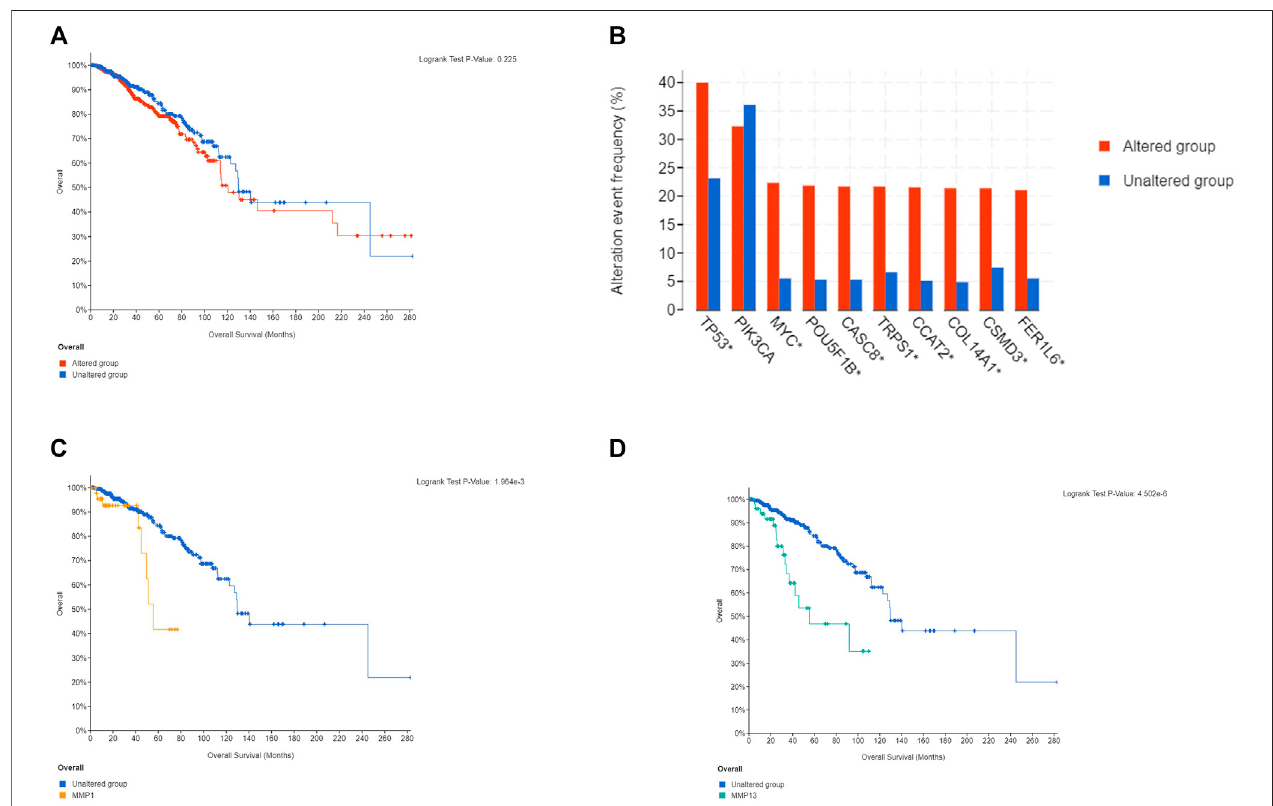
FIGURE 6 | Histogram of genes with the highest frequency in the genome and MMPs survival curve. (A) Overall survival curve of MMP family. (B) Histogram of genes with the highest frequency in the genome. (C) MMP13 overall survival curve. (D) MMP1 overall survival curve.